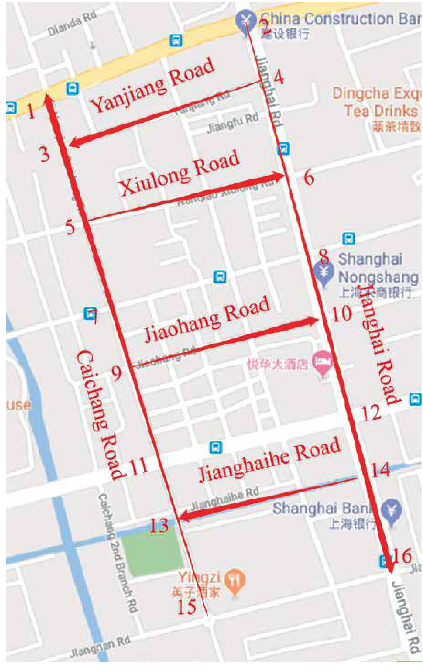
Table 4: One-way traffic flow ratio of each road segment in peak hours.